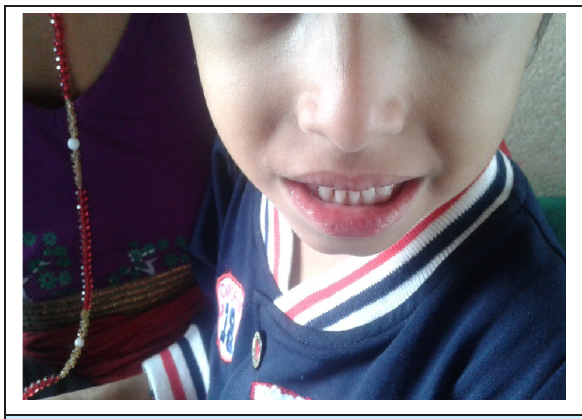
Figure 1. Mucosal changes and lip cracking.